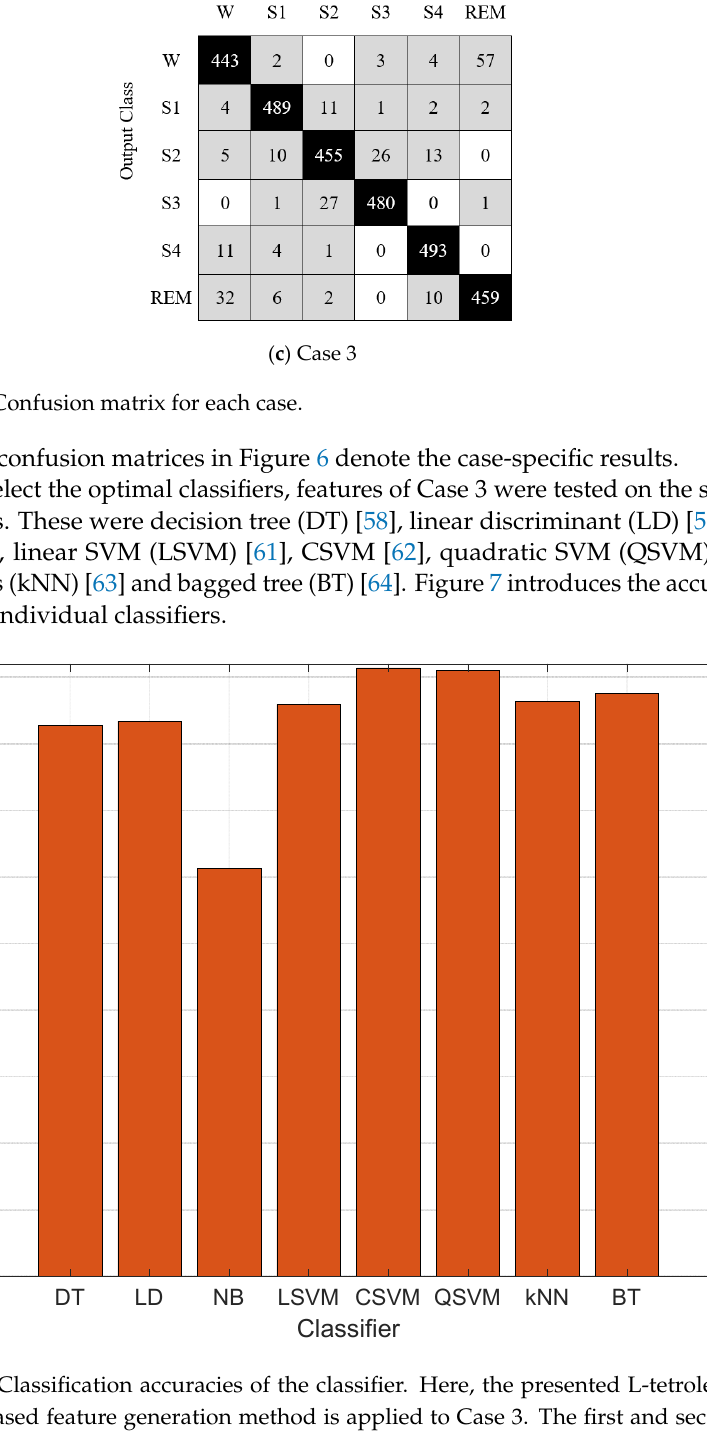
Figure 7. Classification accuracies of the classifier. Here, the presented L-tetrolet and maximum pooling-based feature generation method is applied to Case 3. The first and second layers of the TSRFINCA are applied to these features to eliminate the redundant feature, and NCA selected 1000 features for tests.